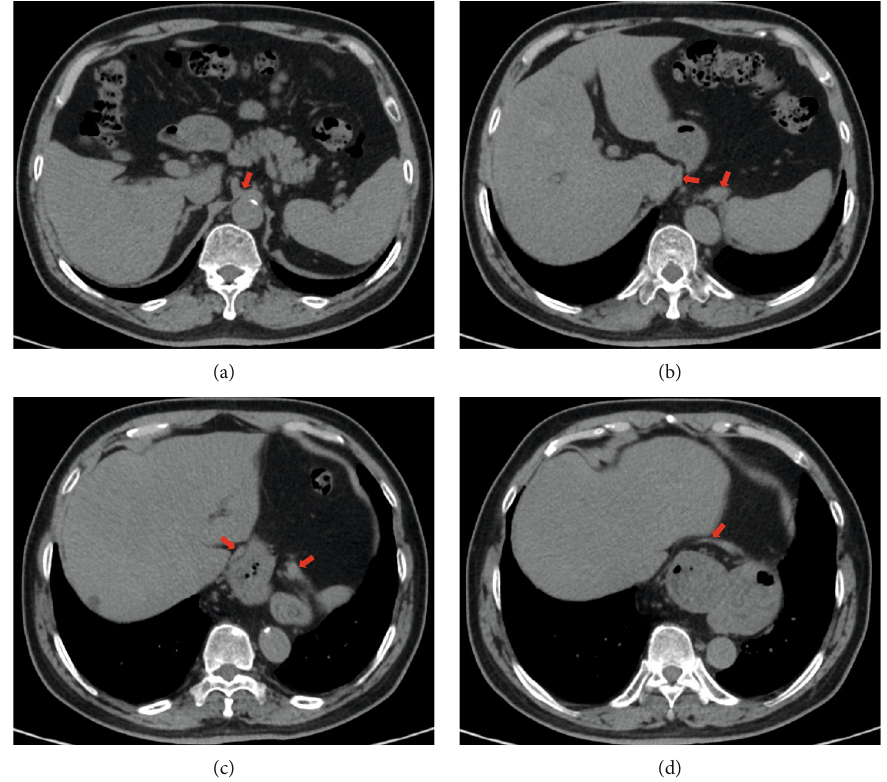
Figure 2: CT images showed the diaphragmatic crura from bottom to top: (a) the red arrow indicated the position where left and right crura began to separate; (b, c) the red arrow indicated the separated crus; (d) the red arrow indicated the left and right crus